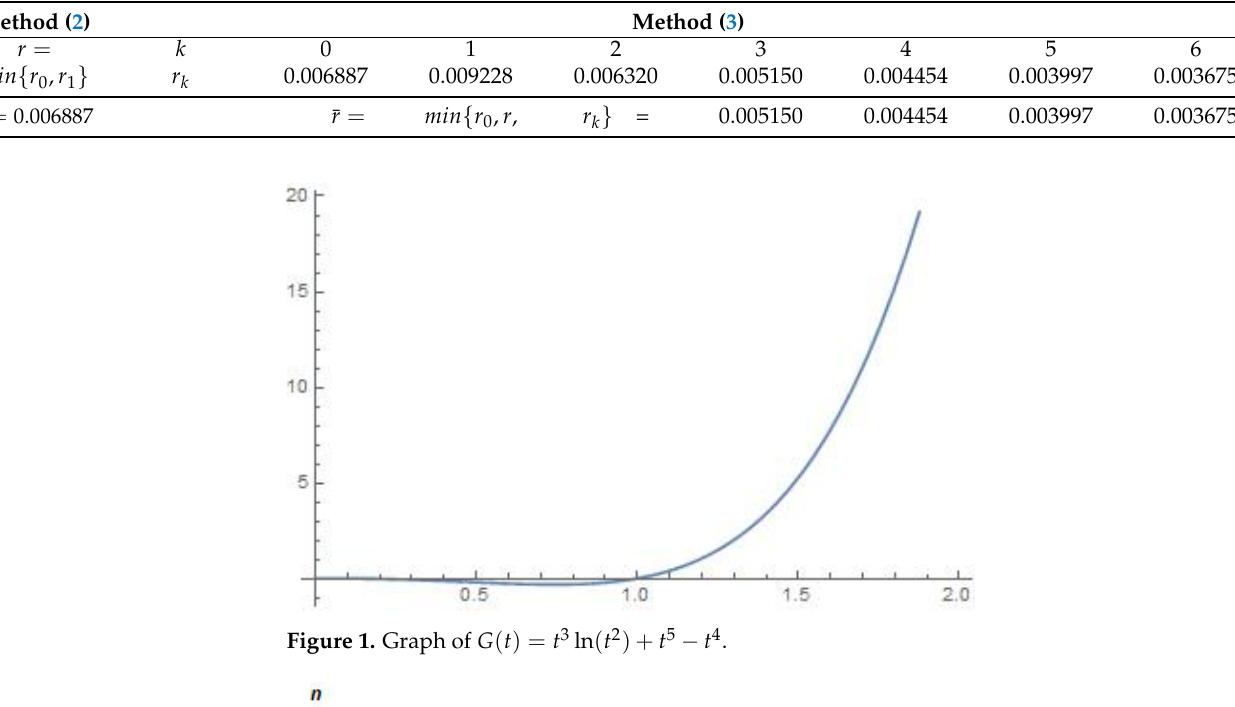
Table 5. Estimates for Example 5.